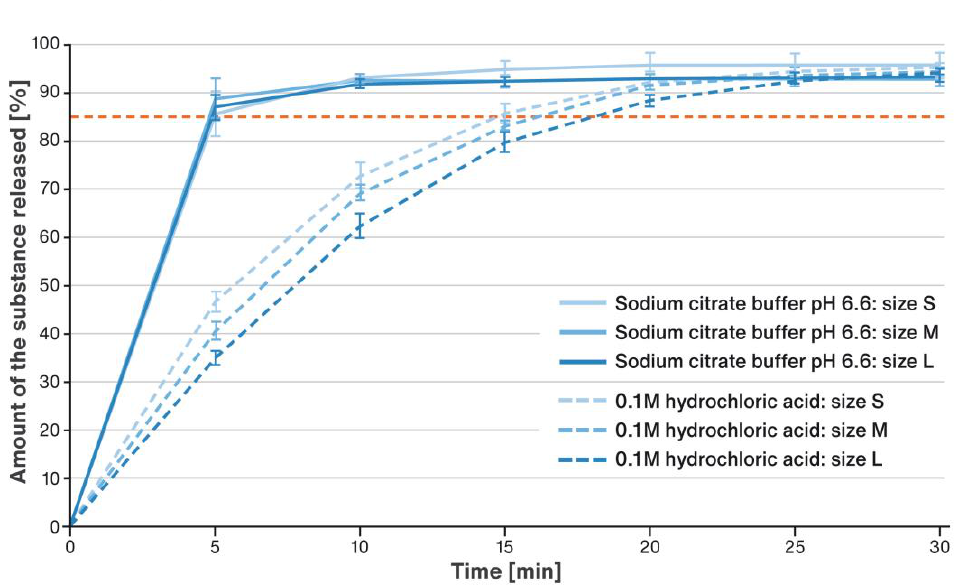
Figure 6. Comparison of the amount of RSC released from S, M, and L size sprinkle multiparticu- lates during contact with a soft food or liquid; mean values with n = 3, SD is indicated by error bars.